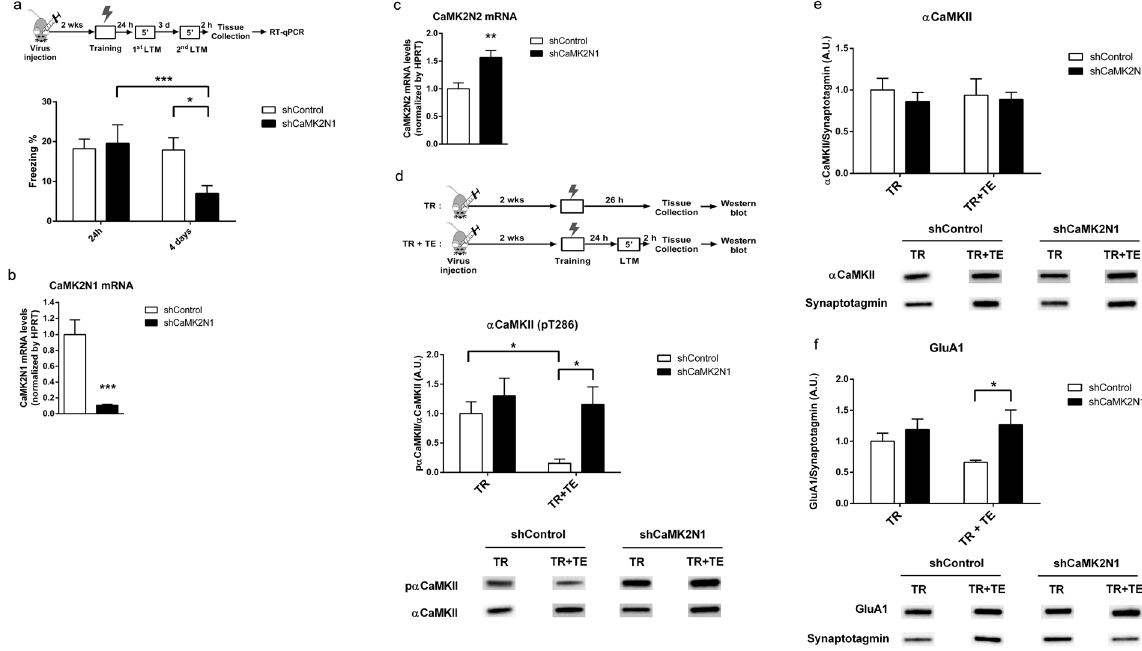
Figure 3. CaMK2N1 expression is necessary for contextual fear LTM maintenance after retrieval and regulates synaptic CaMKII T286 autophosphorylation and GluA1 levels. ( a ) Dorsal hippocampi of mice were transfected with rAAV expressing either control shRNA (n = 15) or CaMK2N1 shRNA (n = 11). Contextual fear LTM was determined one day after conditioning and for a second time 4 days after conditioning. CaMK2N1 shRNA expression in hippocampus impaired contextual fear LTM after retrieval. ( b ) All mice in ( a ) had a significant knockdown of CaMK2N1 mRNA expression in hippocampus. ( c ) In this cohort of mice, knockdown of CaMK2N1 caused a significant increase in CaMK2N2 mRNA expression. ( d ) To understand the retrieval- induced effects of CaMK2N1 knockdown mice were treated with shCaMK2N1 rAAV treatment and trained and tested (TR + TE) in the CFC paradigm or just trained (TR). Dorsal hippocampi samples were collected 2 hours after retrieval of contextual fear LTM, and protein samples prepared for western blots. Retrieval of contextual fear LTM significantly decreased α CaMKII autophosphorylation at T286 in synaptosomes (shControl: TR, n = 7, TR + TE, n = 5). This decrease in T286 autophosphorylation was impaired by shCaMK2N1 expression (TR, n = 7; TR + TE, n = 7). ( e ) shCaMK2N1 expression did not impact on α CaMKII protein levels (shControl: TR, n = 7, TR + TE, n = 6; shCaMK2N1: TR, n = 7; TR + TE, n = 7) (see statistics on Supplementary Table S4). ( f ) Quantification of GluA1 synaptosomal levels of the same cohort of animals revealed a retrieval-dependent increase due to CaMK2N1 knockdown (shControl: TR, n = 6, TR + TE, n = 5; shCaMK2N1: TR, n = 7; TR + TE, n = 7). Example immunoblotting staining for these proteins can be found below each graph and in Supplementary Fig. S7. Mean and S.E.M.; * P < 0.05; ** P < 0.01; *** P <